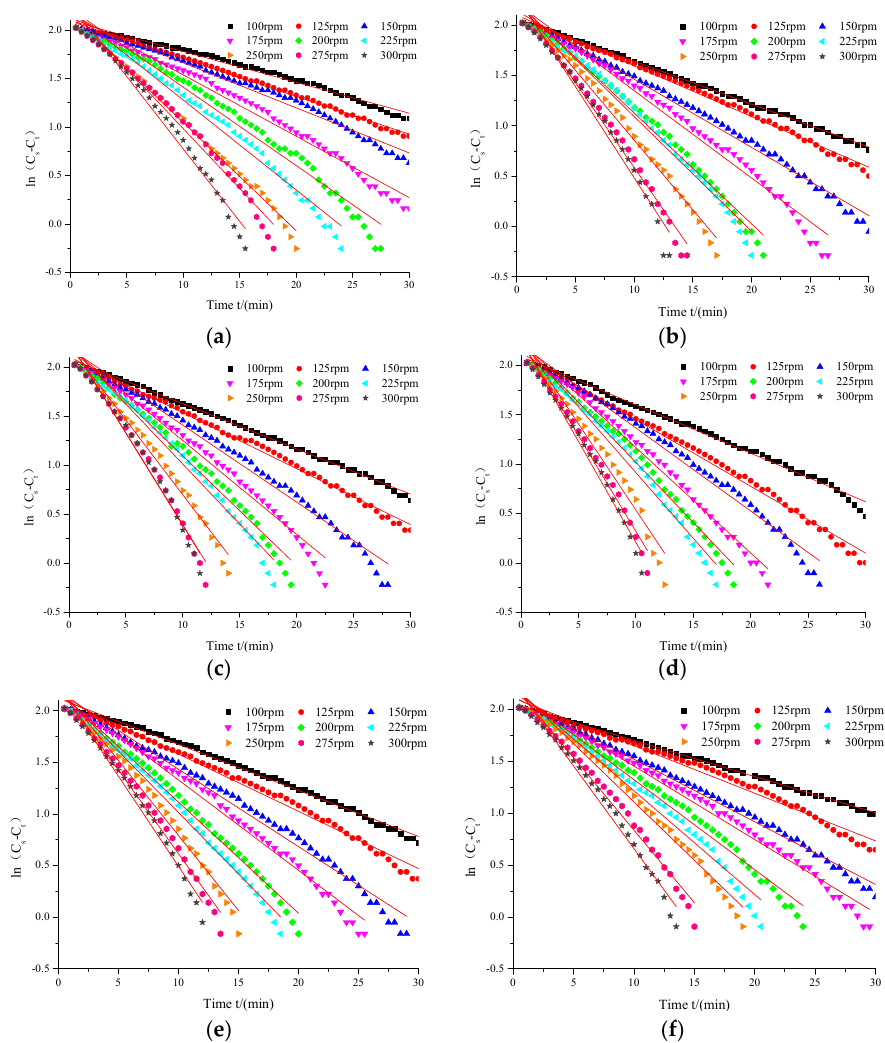
Figure 5. ln (C s − C t ) at different immersion depths. ( a ) +10 mm; ( b ) +5 mm; ( c ) 0 mm; ( d ) −5 mm; ( e ) −10 mm; ( f ) −15 mm.